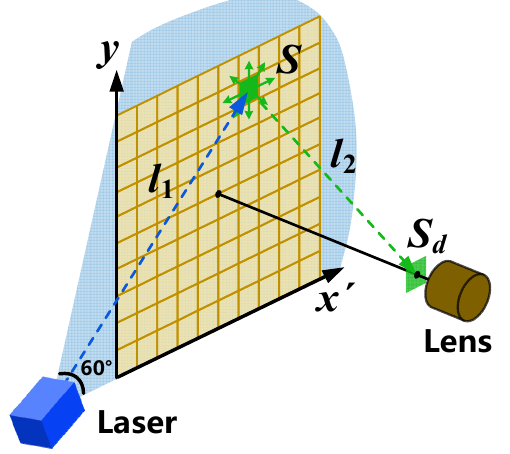
Figure 5. Schematic of fluorescence